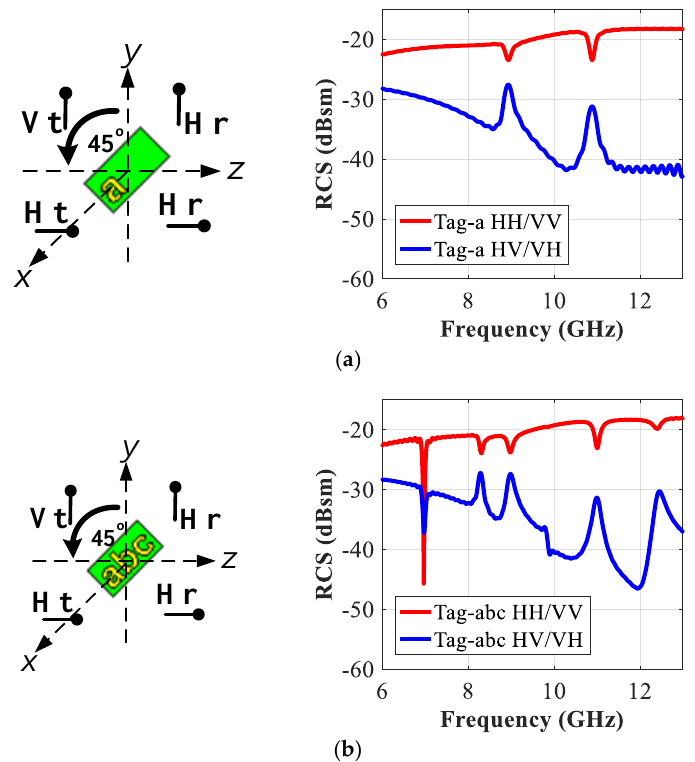
Figure 15. RCS simulation results of tag oriented to 45° in both co- and cross-polarizations: ( a ) Tag-a; ( b ) Tag-abc.